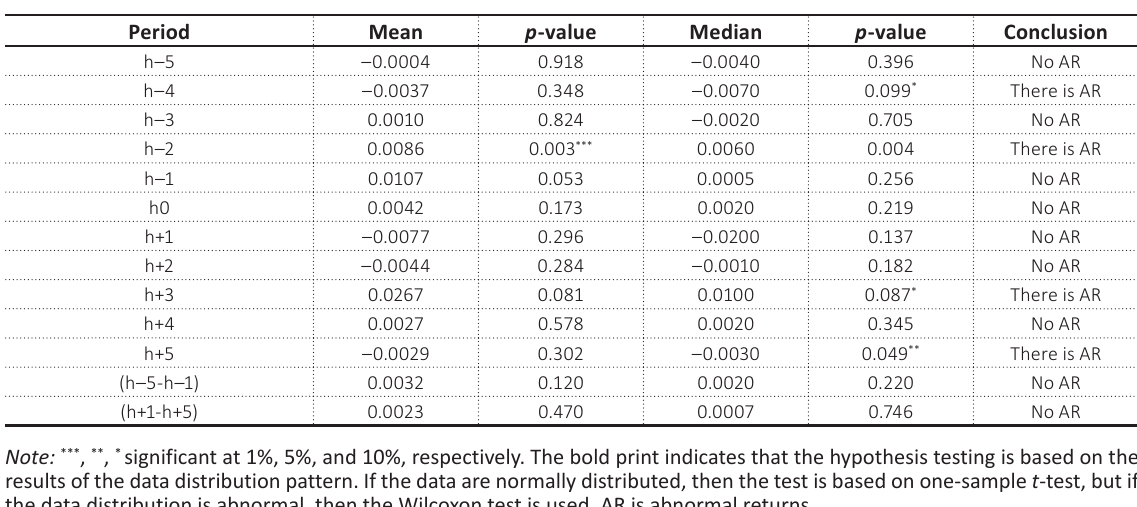
Table 5. Summary of first hypothesis testing results